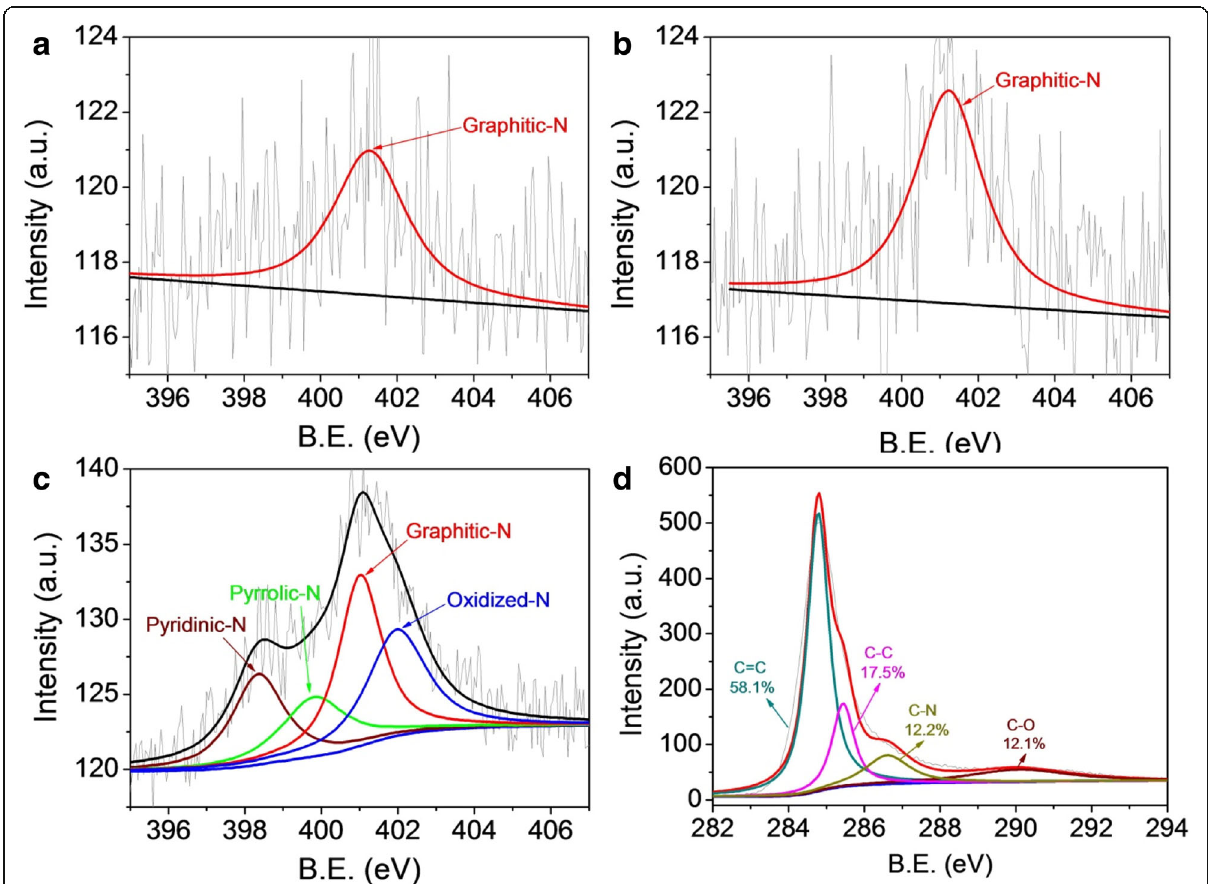
Fig. 4 High-resolution N1s XPS spectra of CF-900 ( a ), CFZ-900 ( b ), and Me-CFZ-900 ( c ). (d ) High-resolution C1s XPS spectra of Me-CFZ-900 ( d 0.2 – 0.8 V versus RHE, which indicates a quasi-four-electron pathway for ORR process being